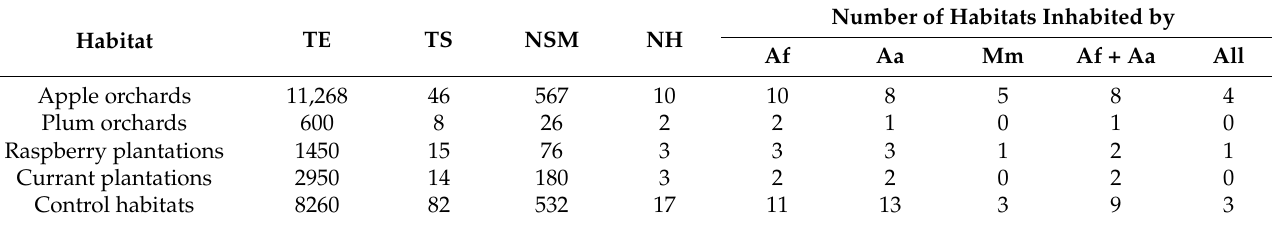
Table 1. Sympatry of granivorous rodents in fruit orchards, berry plantations, and control meadows of Lithuania, 2018–2020. Abbreviations: TE, trapping effort, trap days; TS, number of trapping sessions; NSM, number of all small mammals trapped; NH, number of habitats investigated; Af, A. flavicollis ; Aa, A. agrarius ; Mm, M. minutus ; Af + Aa, by two species living syntopically; and All, by all three species living syntopically.